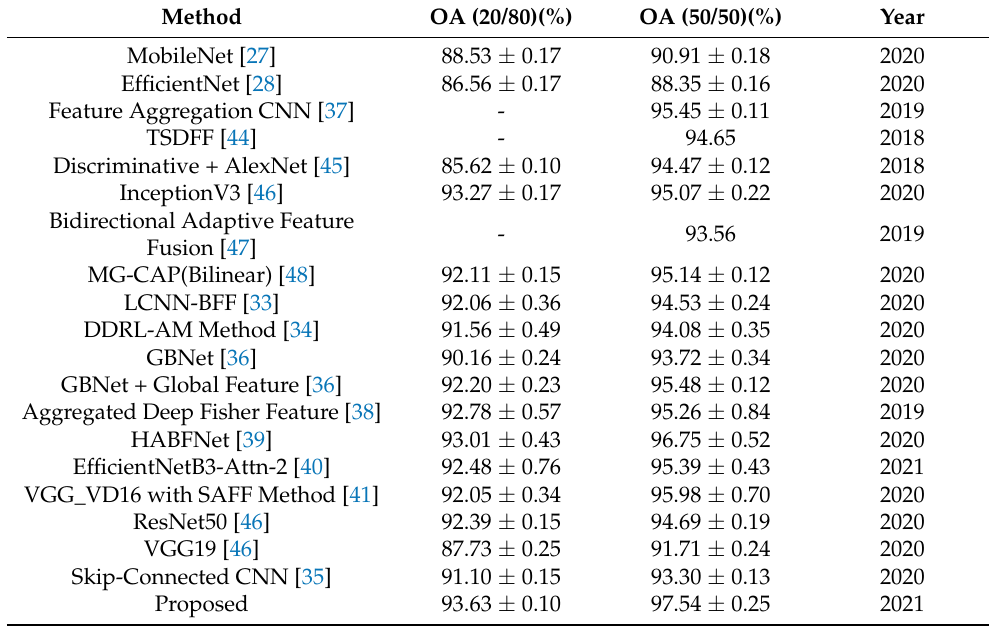
Table 7. Kappa (%) of fourteen methods and the LCNN-CMGF method at the training ratio of 50% in the AID dataset.